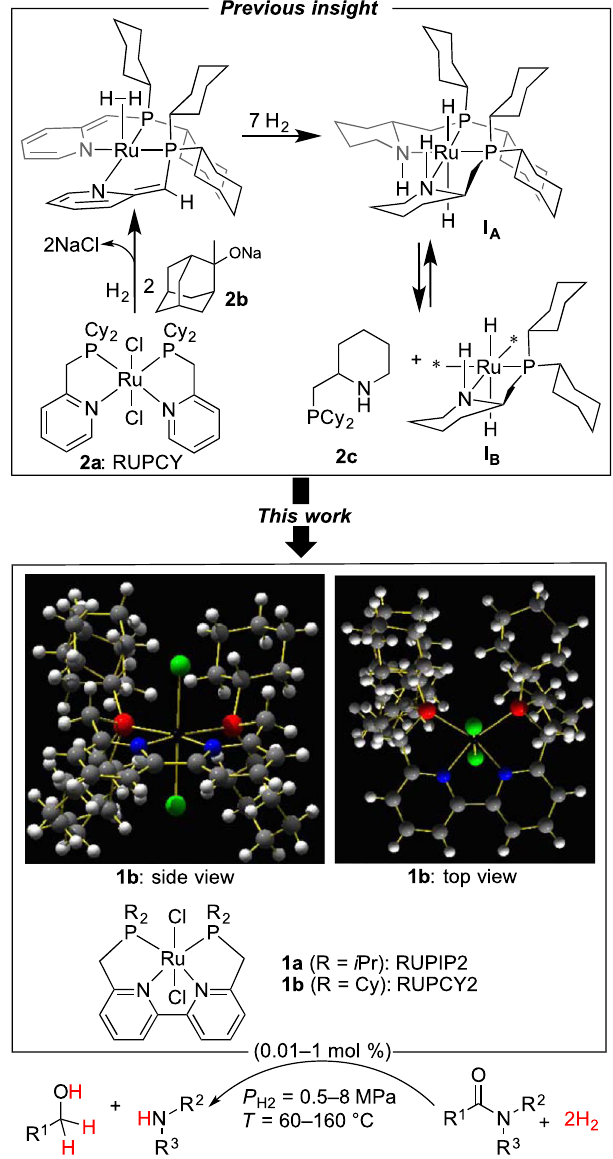
Figure 1. Summary of this work. Our earlier work (in the upper square) illuminated possible catalysts I A and I B derived from 2a , which is modified to new Ru complexes 1a and 1b (in the lower square); and the X-ray single crystal structure of 1b . Ru (black), Cl (green), N (blue), P (red), C (grey), H